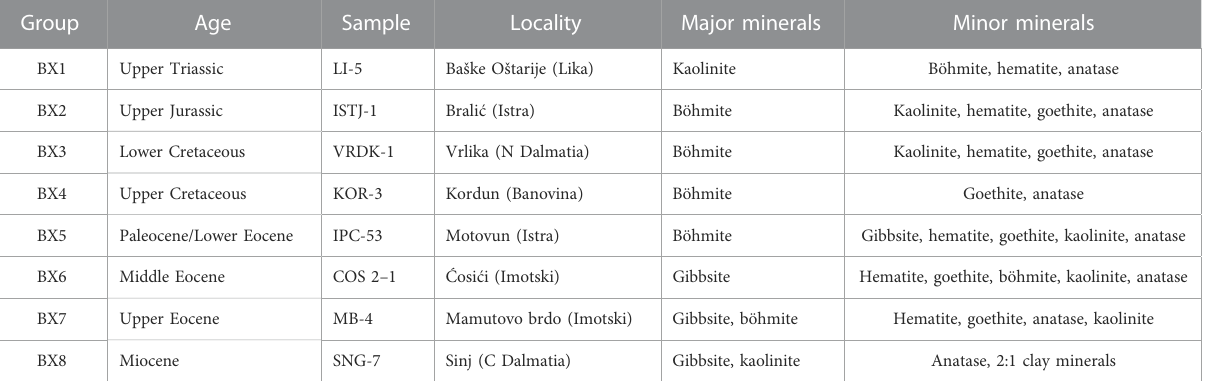
TABLE 1 Mineralogical composition of characteristic bauxite samples from each analyzed karst bauxite